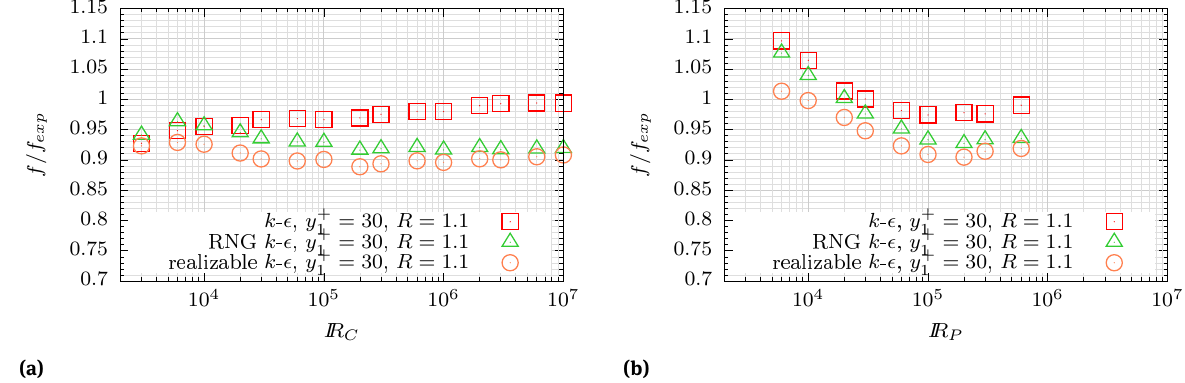
Figure 11: Relative error of friction factor from LWF treatment for circular pipes (left) and parallel plates